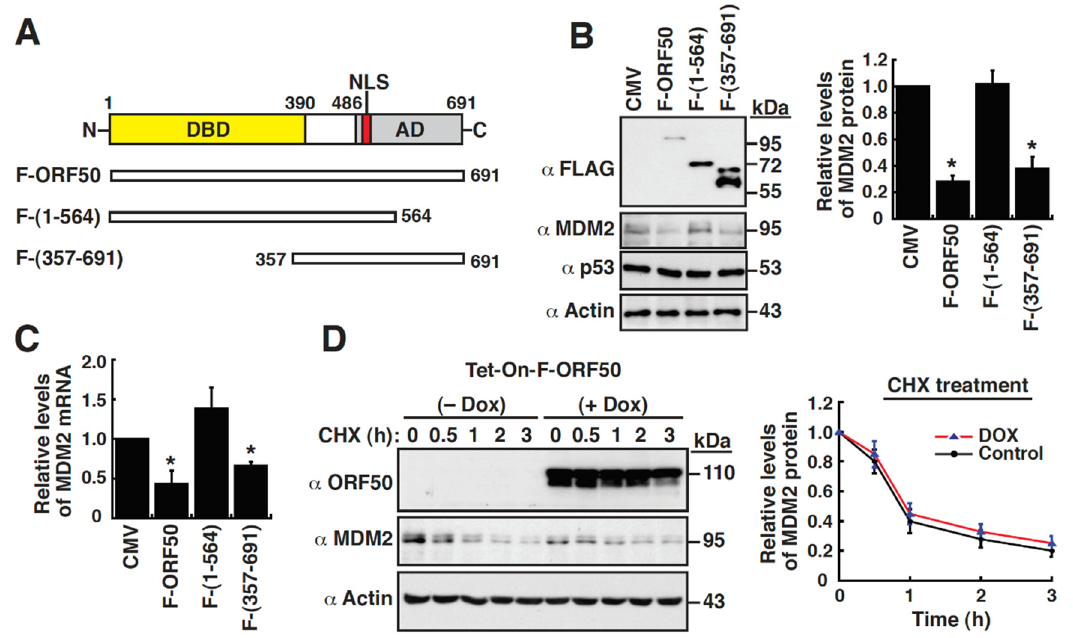
Figure 2. ORF50 transcriptionally downregulates MDM2 expression independently of other viral proteins. ( A ) Schematic diagram of ORF50 and its deletion constructs. Specific functional domains or motifs of ORF50 protein are indicated as follows: DBD, DNA-binding domain (aa 1–390); AD, activation domain, (aa 486–691); NLS, nuclear localization signal. ( B ) Effect of wild-type or mutant ORF50 on the expression of MDM2 and p53 in 293T cells. 293T cells were transfected with the empty vector or different ORF50 constructs, and then the expression of the indicated proteins in transfected cells was examined by Western blotting. Quantitative data of MDM2 expression in transfected cells are indicated as mean ± SEM (n = 3). *, p < 0.05, for results compared to those with the empty vector control. ( C ) Quantitative RT-PCR analysis of the MDM2 mRNA levels in 293T cells transfected with the empty vector or different ORF50 constructs. Levels of the MDM2 mRNAs in transfected cells were normalized with the levels of 18S rRNA. *, p < 0.05, for results compared to those with the empty vector control (n = 3). ( D ) Analysis of protein stability of MDM2 in HH-B2(Tet-On-F-ORF50) cells by cycloheximide chase assays. HH-B2(Tet-On-F-ORF50) cells were left untreated or treated with doxycycline for 16 h, and then the cells were treated with cycloheximide for another 0.5, 1, 2, and 3 h. Western blots for MDM2 expression were quantified by densitometry (n = 3; right panel).